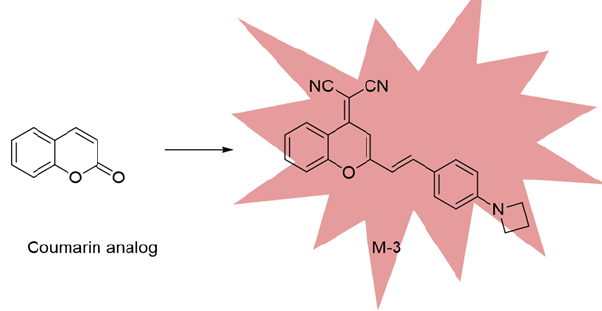
Figure 1. Design of near-infrared small molecule M-3.